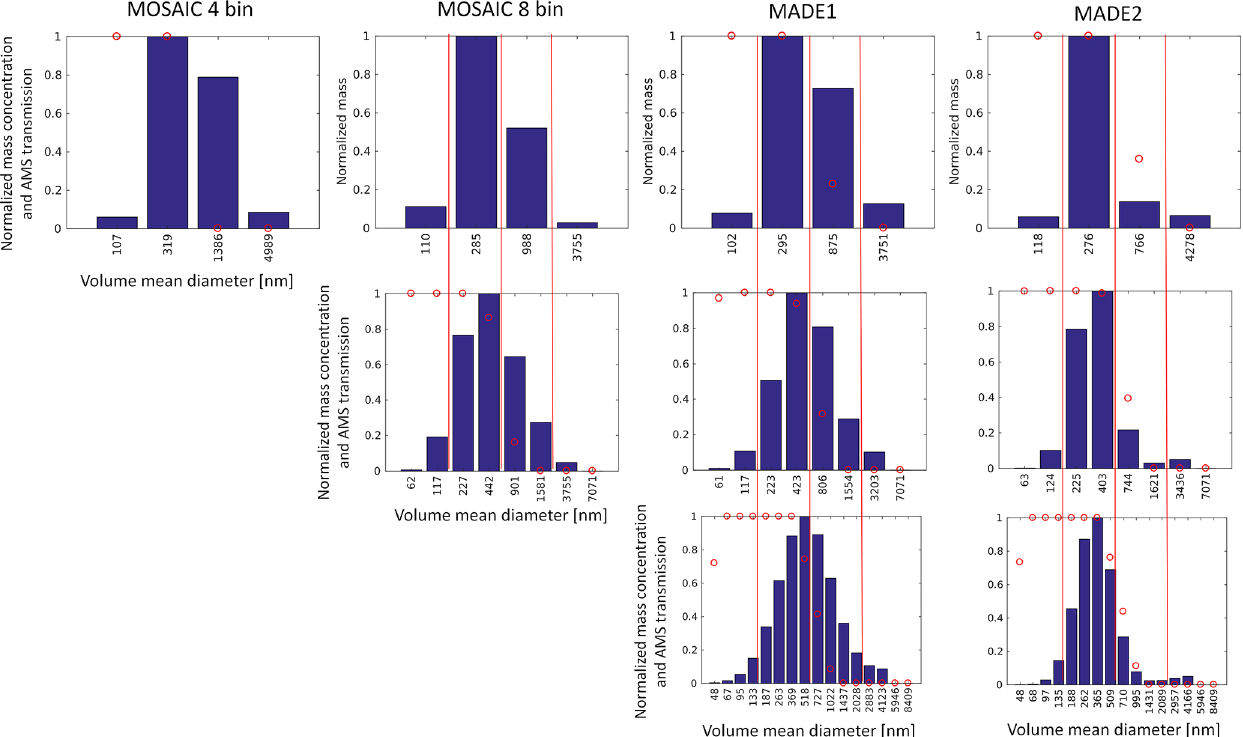
Figure 12. Same as Fig. 8 but for simulations using different modeling configurations. Size bins and AMS transmission efficiency are aggregated to coarser bins when possible for comparison across configurations. Size bin boundaries are defined in Table